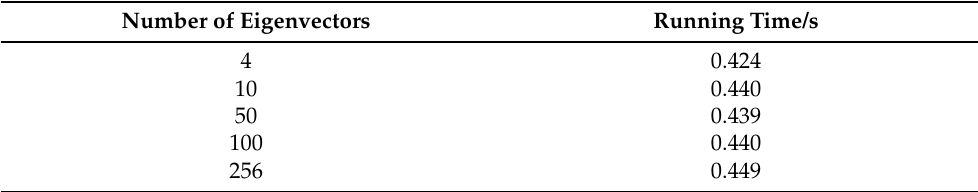
Table 4. Average running time with different numbers of